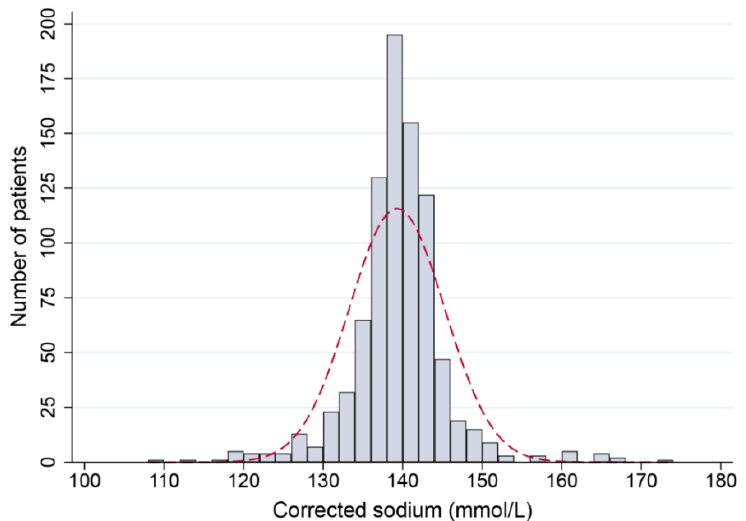
Figure 2. Histogram of admission serum sodium concentrations (corrected for glucose levels) with superimposed normal distribution curve (dashed red line). Each bar represents a 2 mmol/L interval. The peaked distribution curve suggested that severe hypo- or hypernatremia was uncommon.